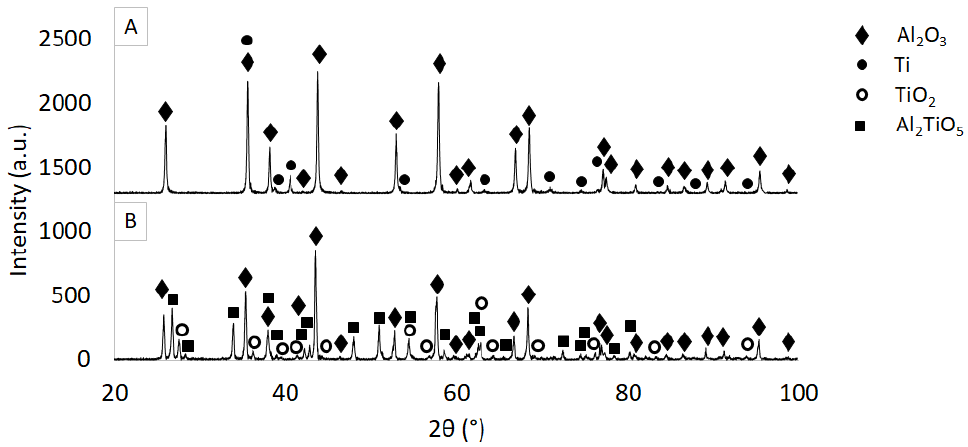
Figure 7. Diffractogram for a selected Al 2 O 3 /Ti sample in the raw state ( A ) and after sintering ( B ).